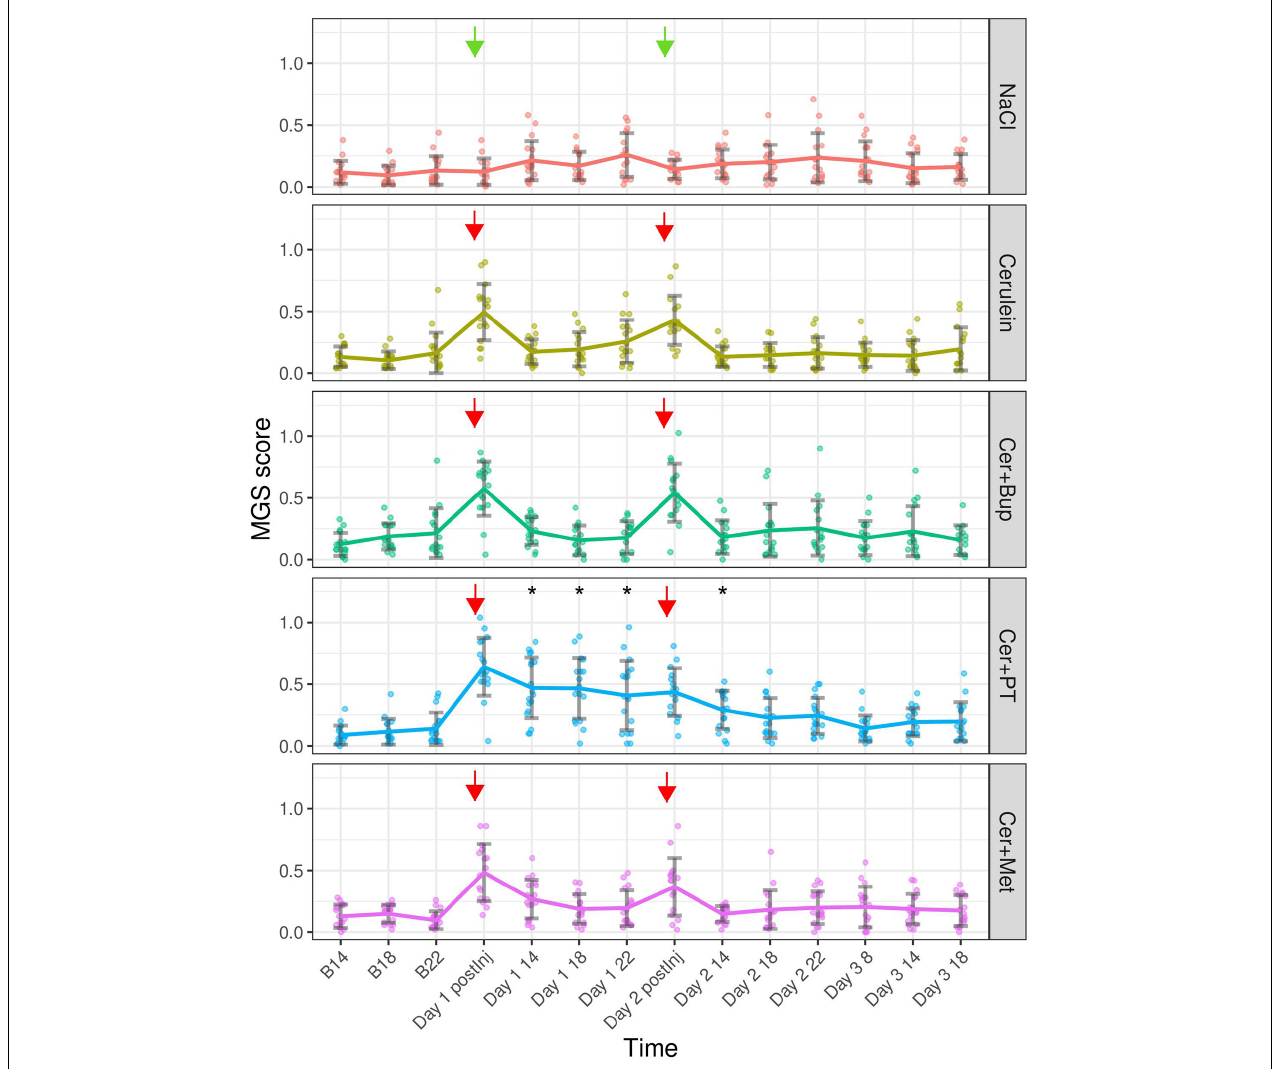
FIGURE 5 | Mouse Grimace Scale scores are shown for each treatment group at baseline (B 14, B 18, and B 22), immediately after the first injection of the day (Day 1 and 2 postInj), and at different time points following the injections. Arrows marking the injection time points (green = NaCl, red = Cerulein). Bonferroni post hoc test detected a significantly lower MGS in NaCl compared with all other Cerulein-treated groups on days 1 and 2 immediately after the first injection. On Day 1 after the injection, Cer showed a lower MGS than Cer + Bup and Cer + PT; at the same time point on Day 2, Cer + Met showed lower scores than Cer + Bup. On Day